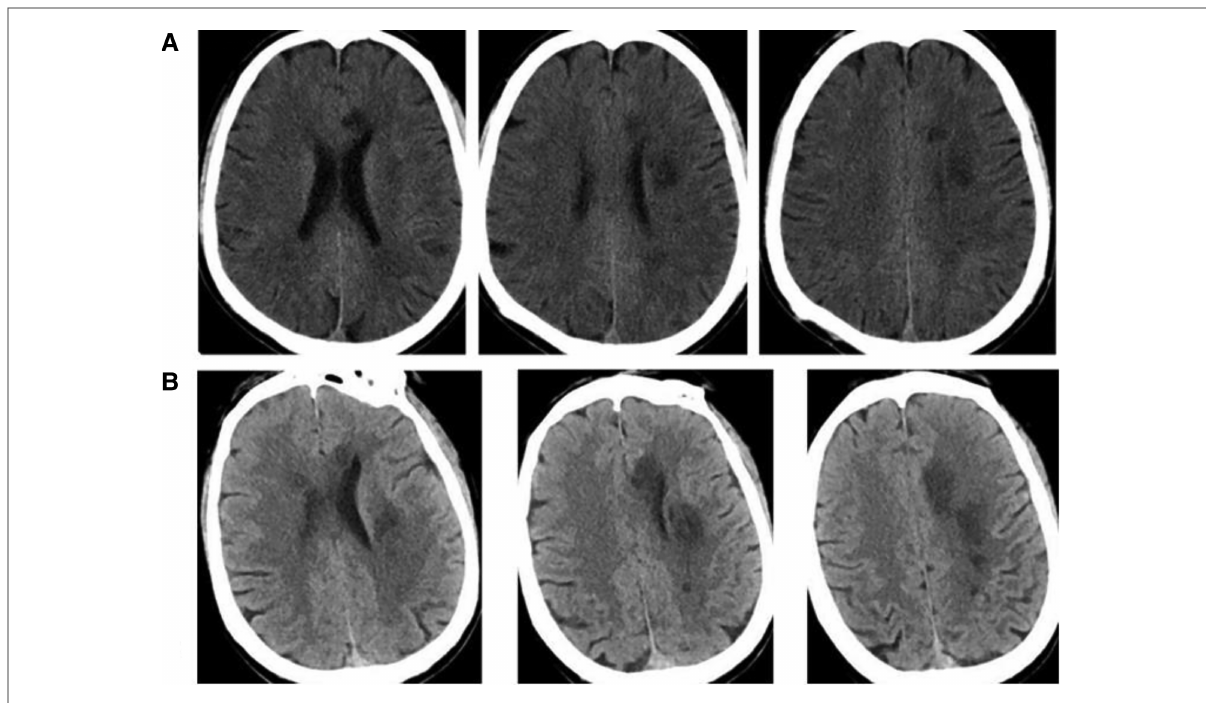
FIGURE 4 ( A ) Brain CT images were reexamined on the day after CAS. ( B ) On the third day after CAS, the brain CT image was reexamined (the low-density focus showing a greater enlargement than before). CAS, carotid artery stent